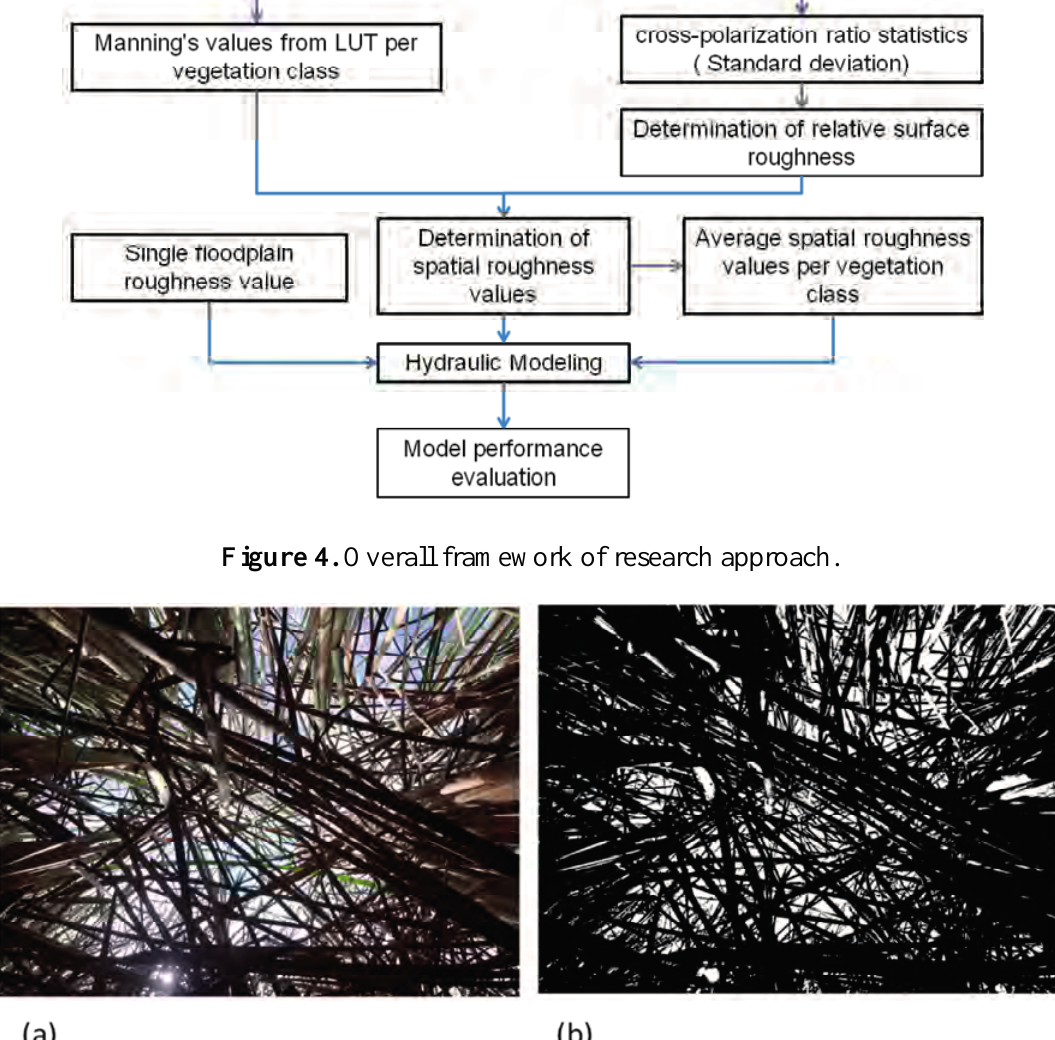
Figure 5. Canopy photos at a reed site ( a ) Vertical photo taken below the canopy ( b ) image after